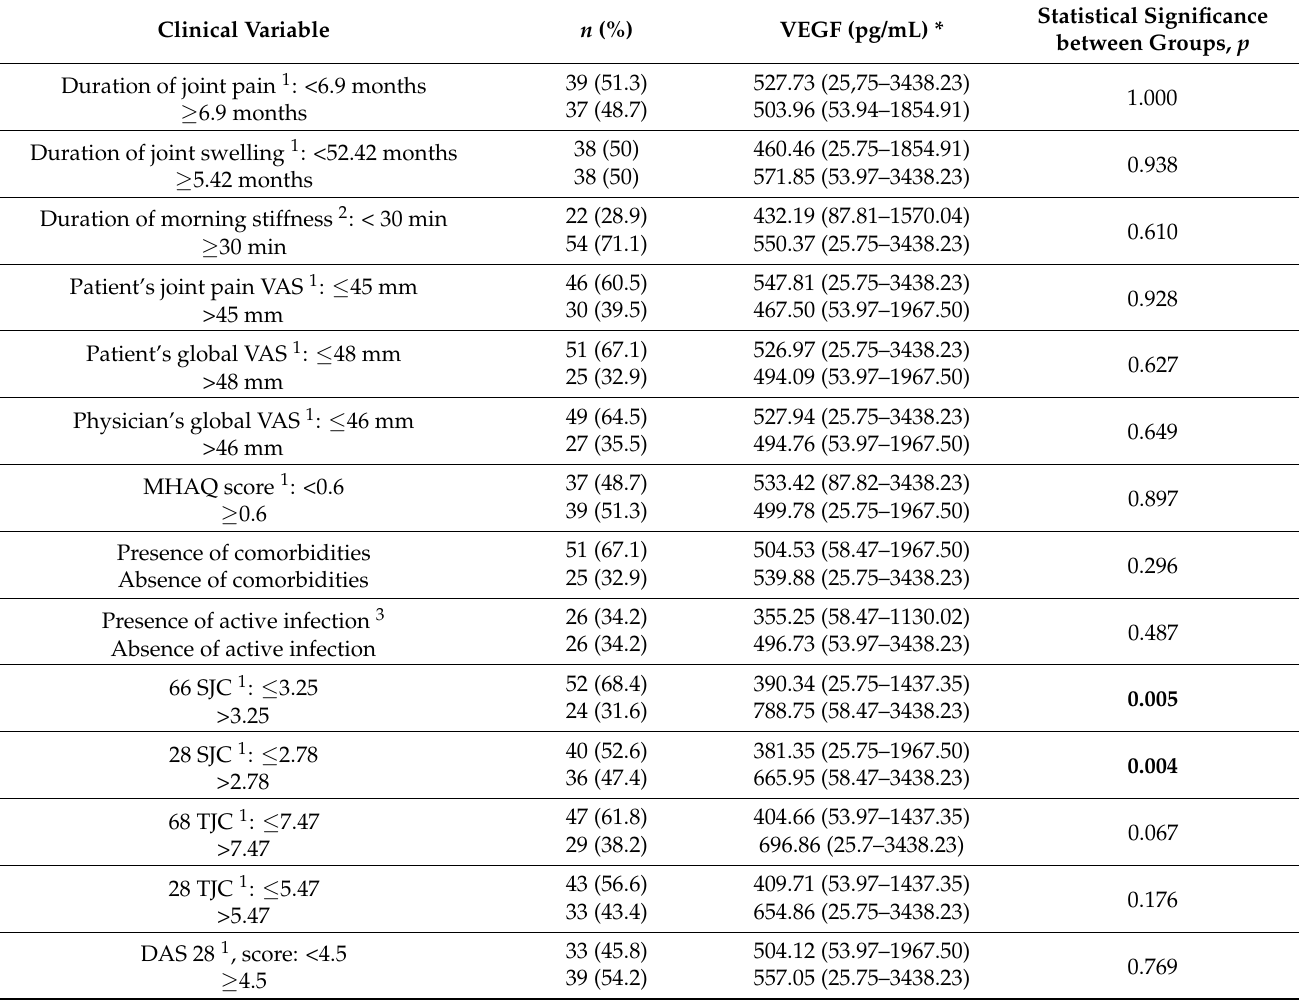
Table 6. VEGF level distribution between early undifferentiated arthritis patient cohort clinical variable data results.